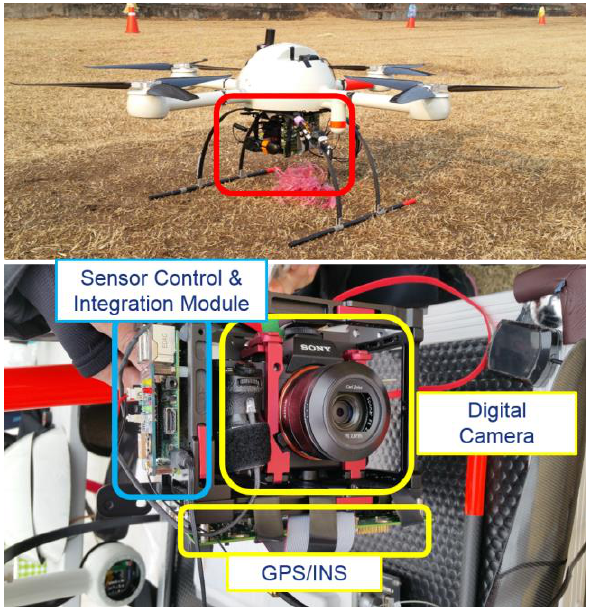
Figure 3. Hardware system of the UAV mapping system